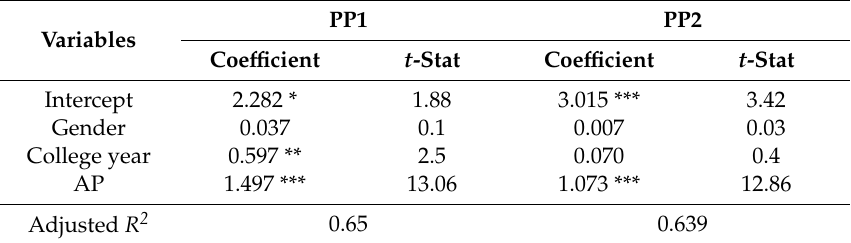
Table 6. E ff ect of active participation on positive perception.